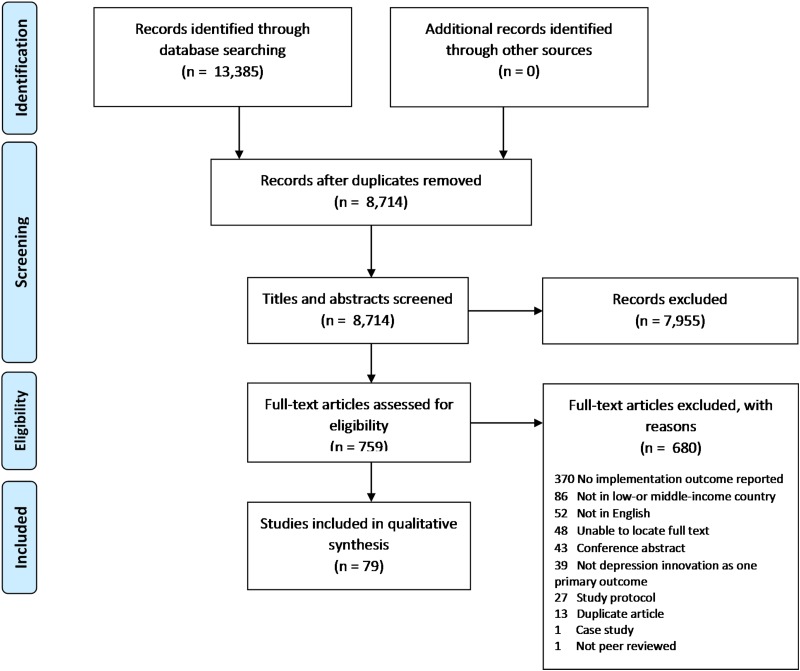
PRISMA flow diagram.